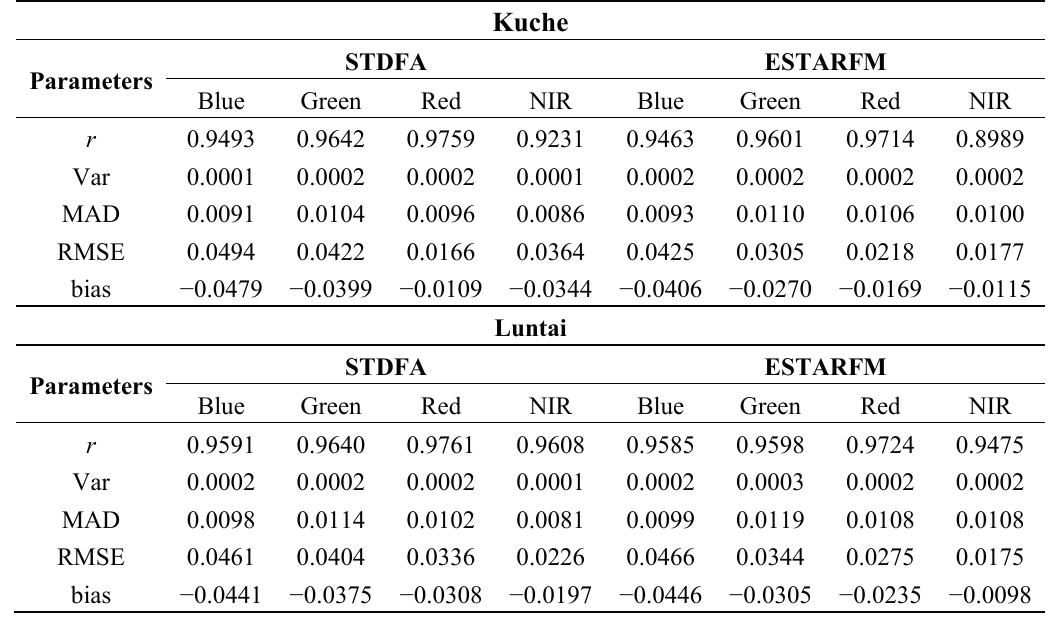
Table 4. Results of the correlation analysis between synthetic and actual HJ CCD